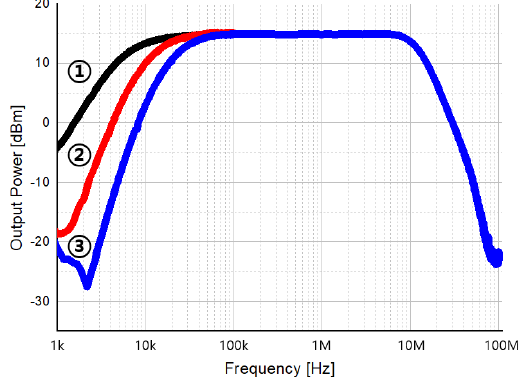
Figure 37. Measurement result of high-pass filter frequency response. Graph 1 (cid:13) is the measurement result with only the DCOC of RF TIA on, and shows the cut-off characteristic of 20 dB/dec and 10 kHz. In the graph 2 (cid:13) , two DCOCs were turned on, and the cut-off characteristics of 30 dB/dec and 20 kHz were confirmed. Finally, graph 3 (cid:13) was measured with three DCOCs turned on, and showed cut-off characteristics of 40 dB/dec, 20 kHz, and it was confirmed that the Doppler frequency can be detected